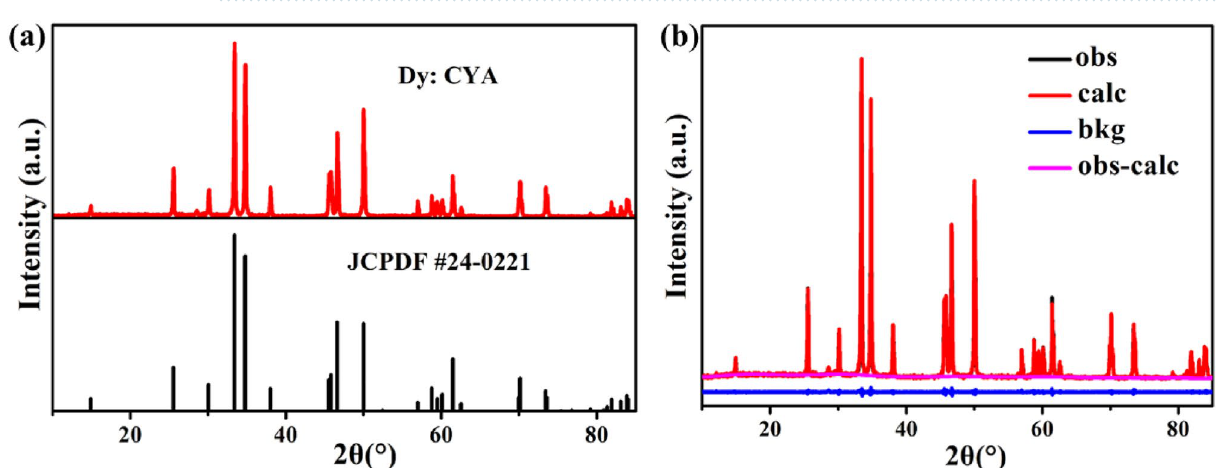
Figure 3. ( a ) XRD pattern of Dy: CYA crystal; ( b ) the refined results of Dy: CYA crystal (the "bkg" refers to the background diffraction peak intensity. The "obs" refers to the experimentally measured raw data, "cal" refers to theoretical simulation data, and "obs-calc" refers to the difference between the